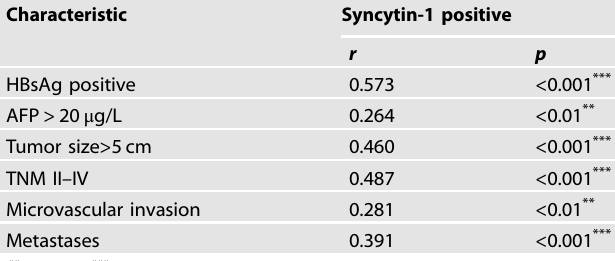
Table 2. Spearman rank correlation analysis of the correlation between Syncytin-1 overexpression and various risk factors in 103 HCC